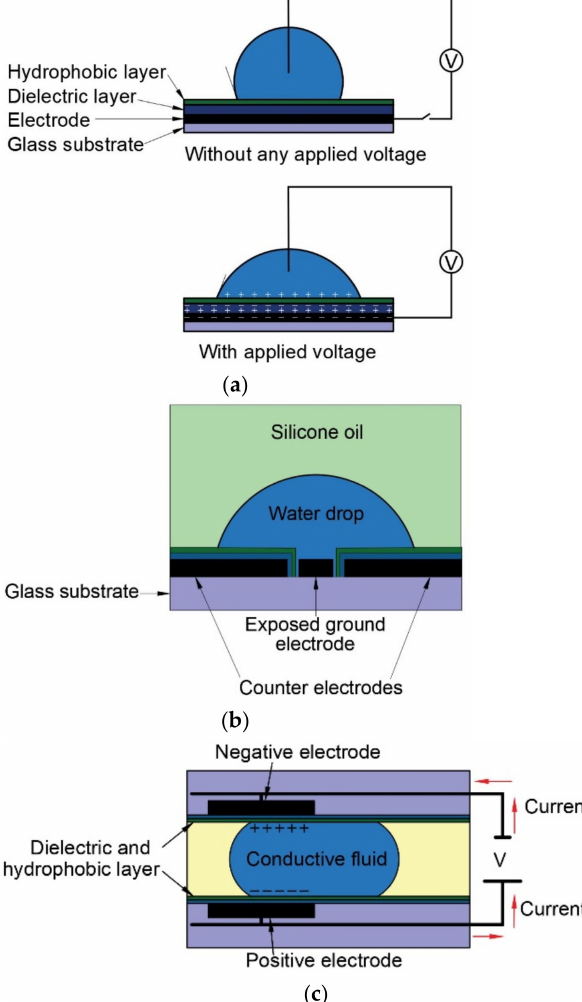
Figure 1. Design types and configurations in recent studies on electrowetting ( a ) sessile-drop elec- trowetting. Adapted from [14], ( b ) co-planar electrowetting. Adapted from [15], ( c ) parallel electrode electrowetting. Adapted from